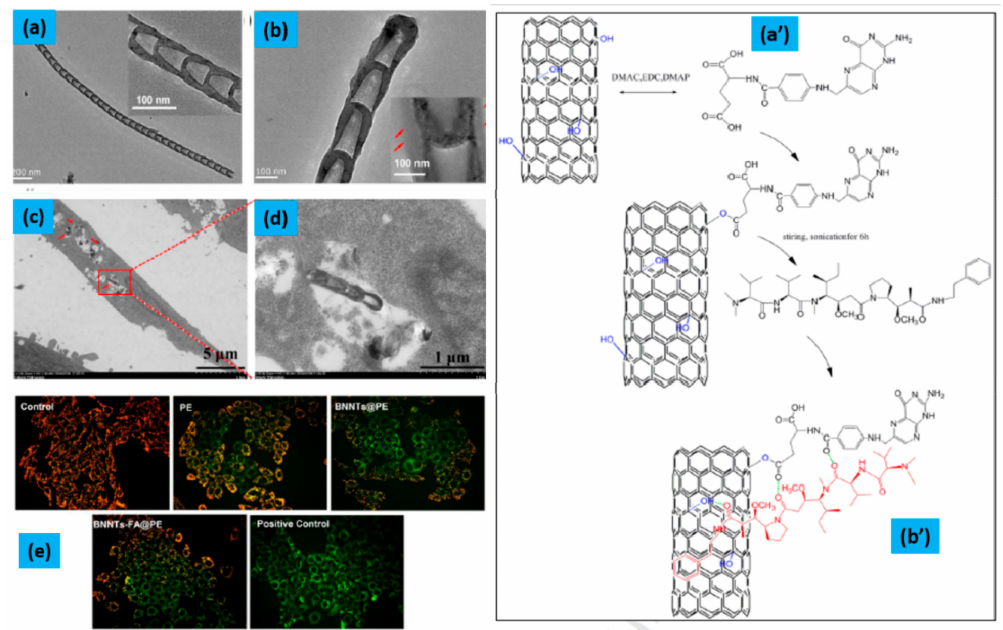
Figure 5. ( a , b ) TEM images of BNNTs-OH and BNNTs-FA@PE, respectively (the insert is the enlarged TEM images); ( a’ , b’ ) represents the BNNT and the conjugation of FA and PE on the surface of a BNNT, respectively; ( c , d ) TEM images of Hep G2 cells incubated with BNNTs-FA for 4 h of Low magnification and high-magnification, respectively; ( e ) the mitochondrial membrane potential ( ∆Ψ ) of control, PE, BNNTs@PE, BNNTs-FA@PE and positive control group, and carbonyl cyanide m -chlorophenylhydrazone was used to conduct positive control (reprint from Ref. [102]).